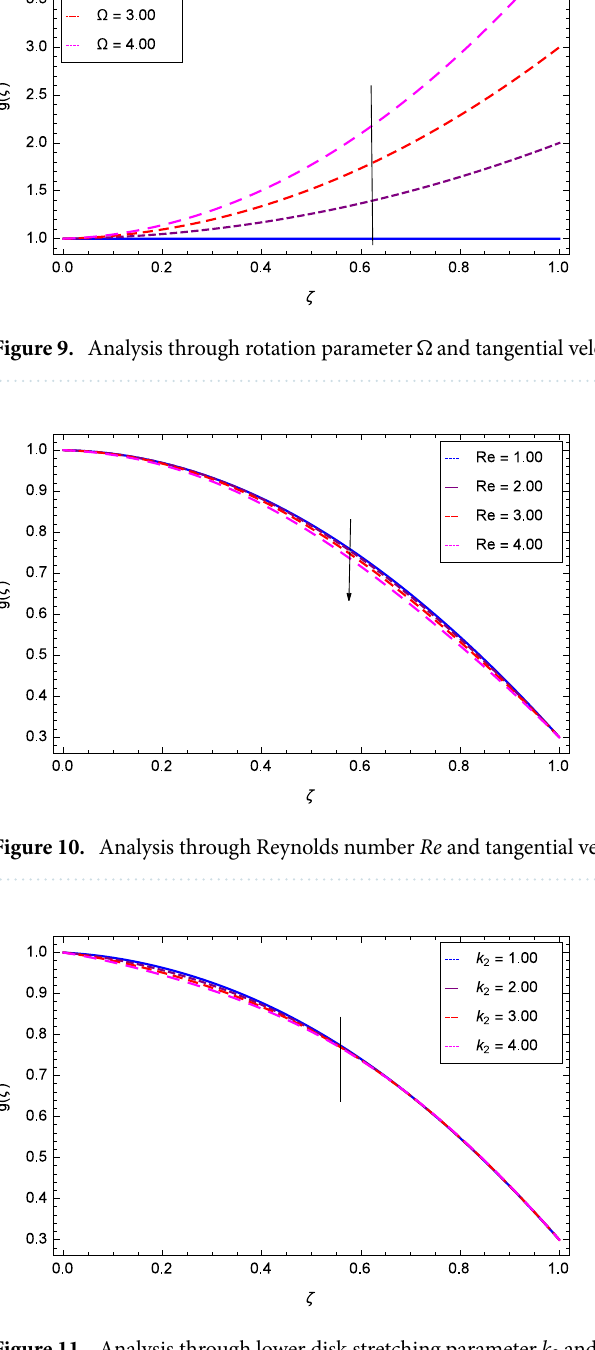
Figure 11. Analysis through lower disk stretching parameter k 2 and tangential velocity g ( ζ